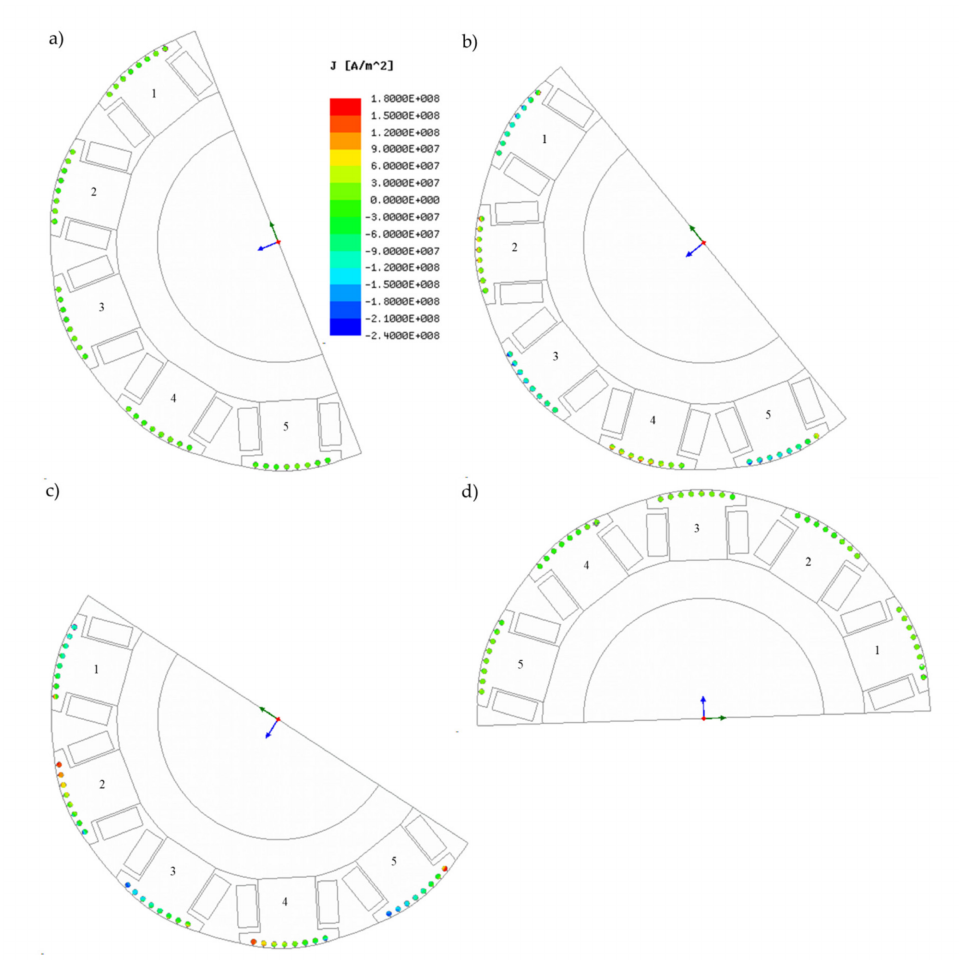
Figure 23. Current densities in rotor bars during out-of-phase synchronization of − 120 ◦ at ( a ) 0.02 s, ( b ) 0.025 s, ( c ) 0.03 s, and ( d ) 0.302